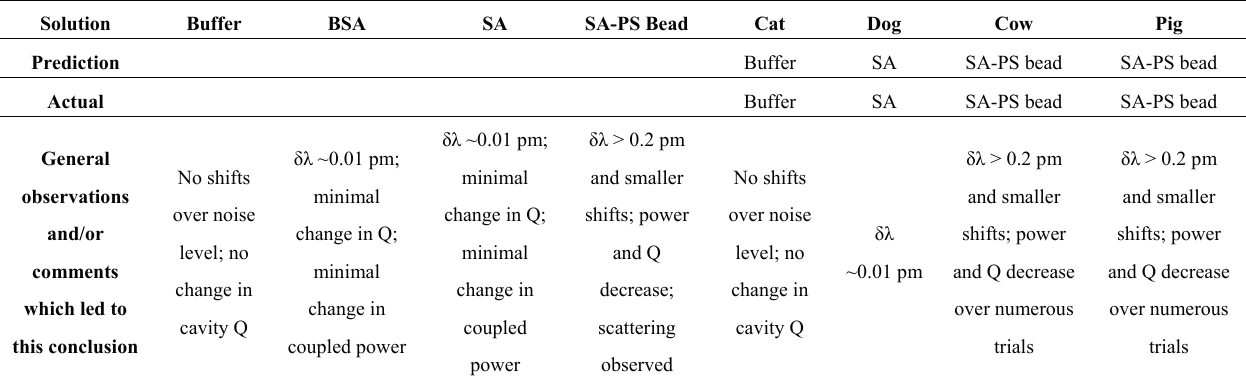
Table 1. Comparison of predicted and actual (known)